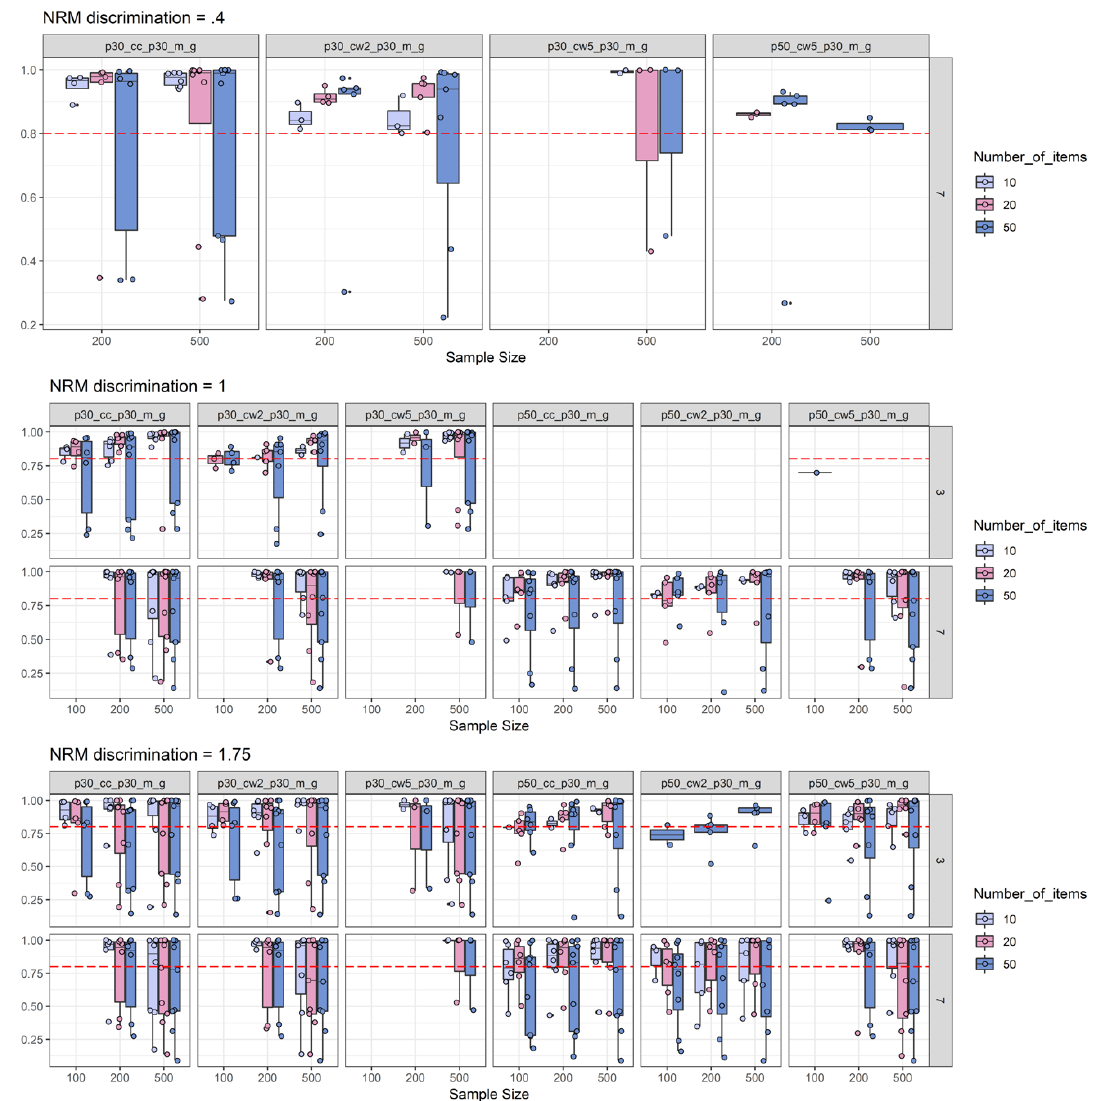
Figure A7. Number-of-items split of empirical power analysis: Depiction of the empirical power (y-axis) under the boundary condition that the average γ is greater than 0.30. Power is depicted as a function of NRM discrimination, sample size (x-axis), number of distractors, number of items, and discrimination effect sizes combined with effect size thresholds. The horizontal red dashed line represents the target power level of 0.80. For more explanations, see Figures 2 and 3.